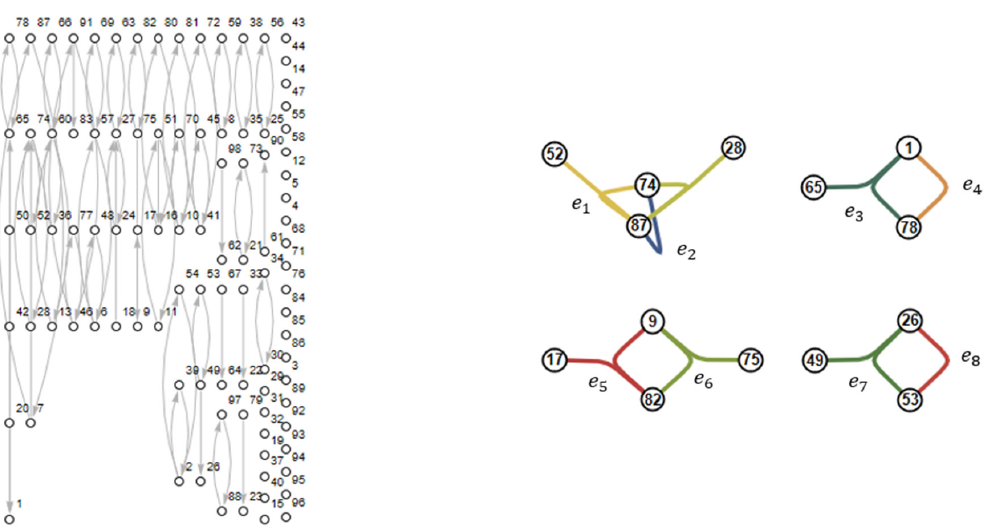
Figure 5. Directed network (on the left) and a network soft set (on the right) representation for the 2018 post-stress economic period. Note: Numbers denote company indices (see Tables A1 and A2) and 𝐸 = {𝑒 (cid:2869) ,𝑒 (cid:2870) ,…,𝑒 (cid:2869)(cid:2876) } is the soft parameter set.